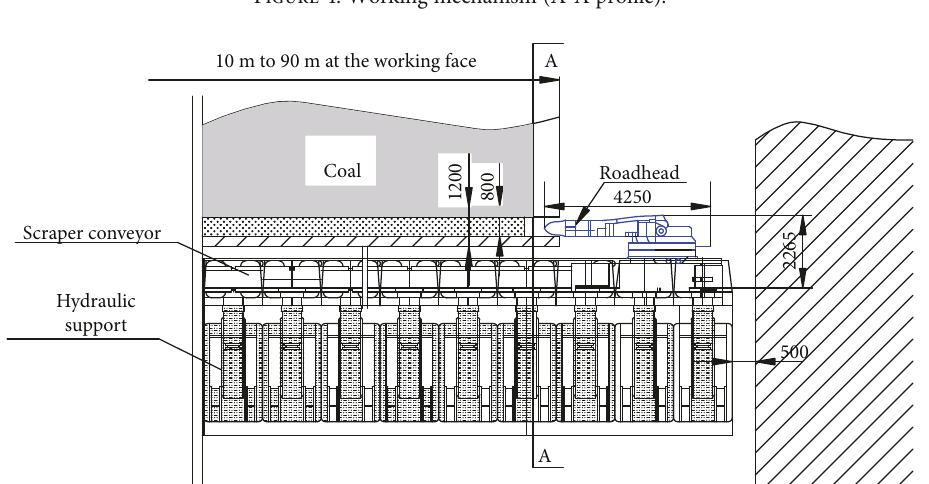
Figure 4: Working mechanism (A-A pro fi le).